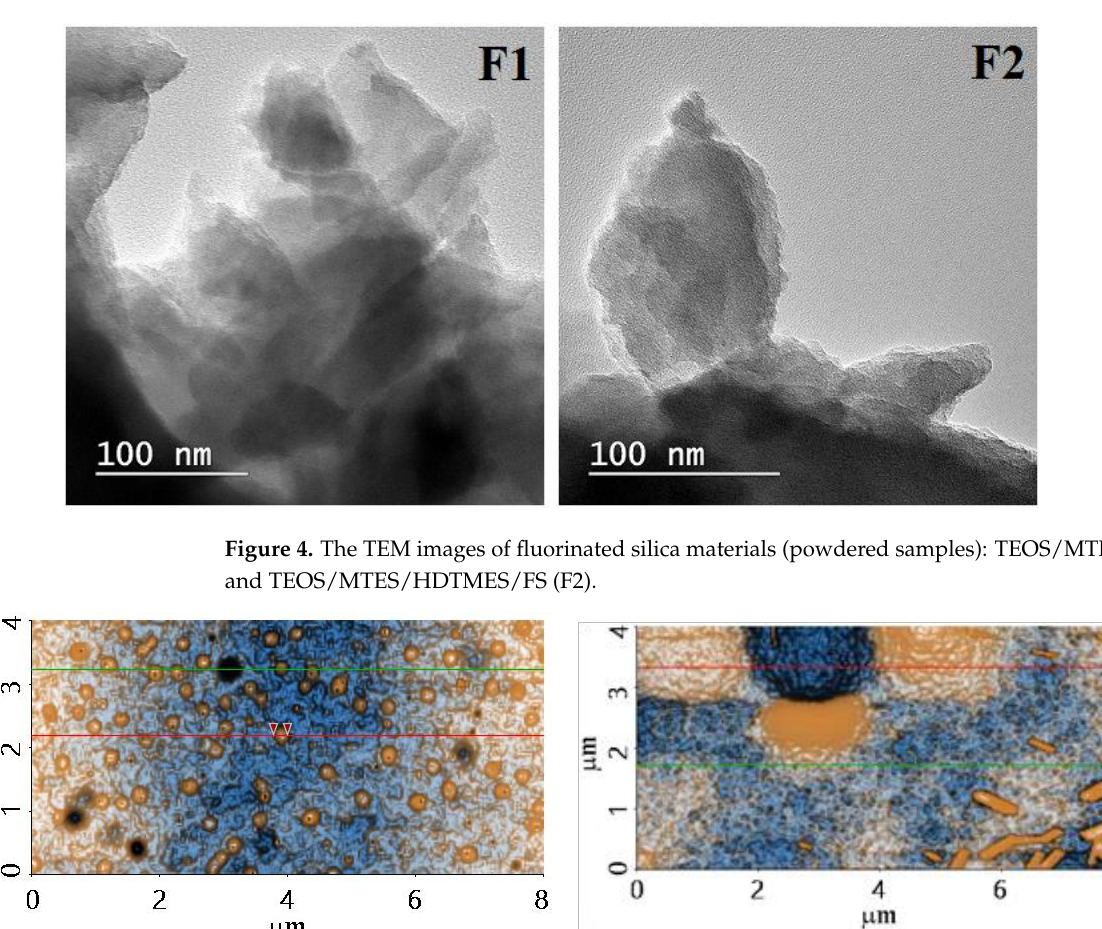
Figure 4. The TEM images of fluorinated silica materials (powdered samples): TEOS/MTES/FS (F1), and TEOS/MTES/HDTMES/FS (F2).